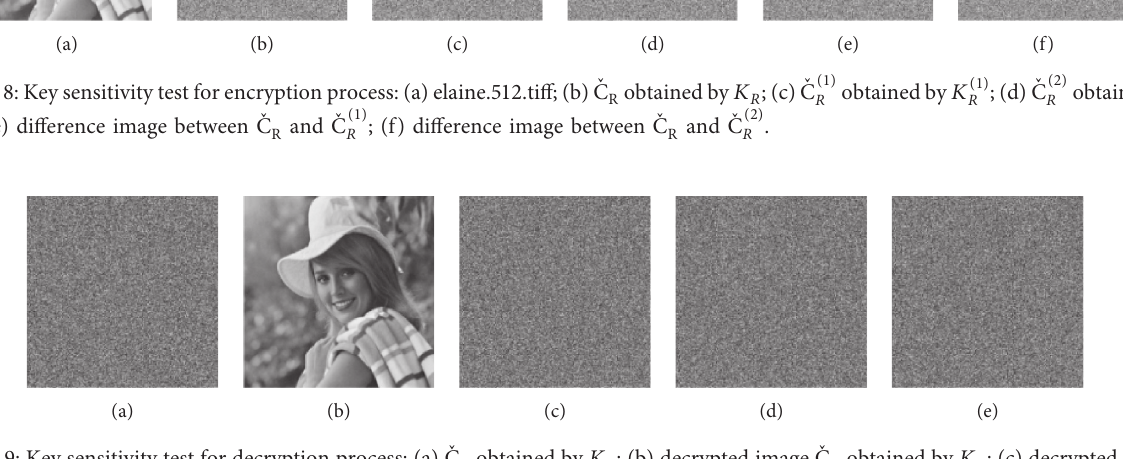
obtained by K R ; (c) decrypted image R ˇC ( 1 ) ˇC ( 2 ) R and R .